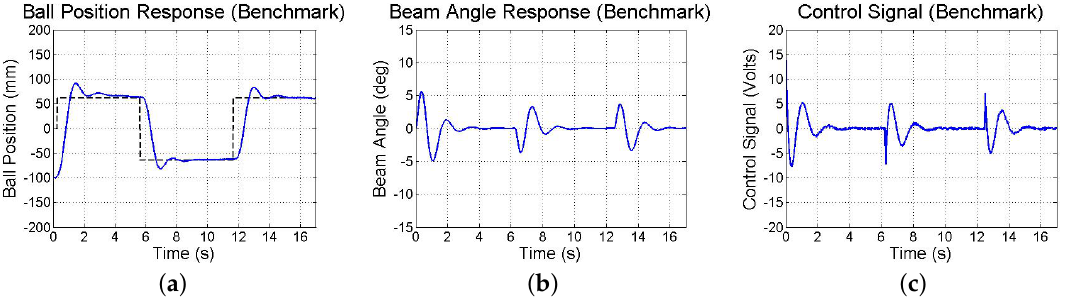
Figure 19. Experimental response of ( a ) ball position; ( b ) beam angle; and ( c ) control action obtained using conventional sensors.